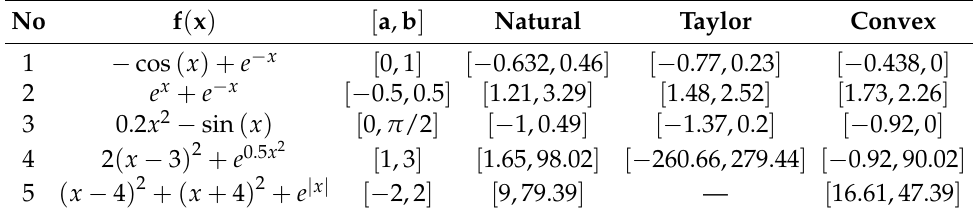
Table 4. Comparison of natural interval expansion (Natural) Taylor expansion (Taylor) and bounds produced by the proposed techniques